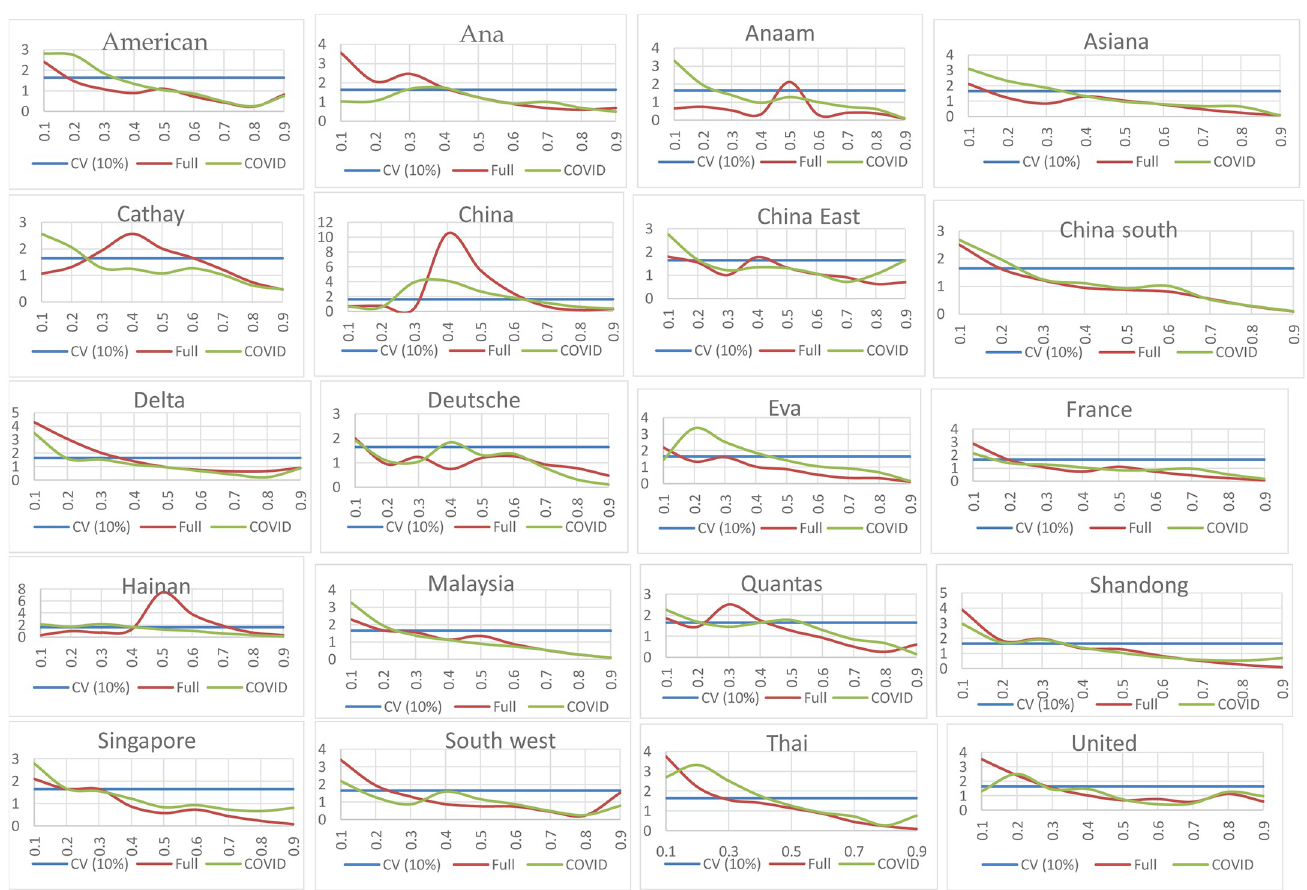
Fig 2. Causality-in-mean result for the airlines. Note: The figure plots the estimates of the nonparametric causality tests of the various quantiles. The y-axis report test statistics and quantiles of the airline stock returns are on x-axis. Full and COVID represents the full sample and COVID-19 pandemic sample, respectively.